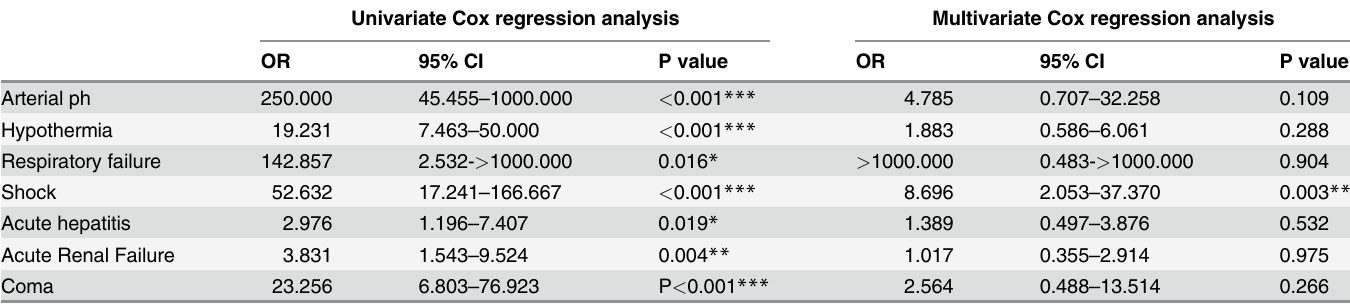
Table 5. Analysis of mortality for patients with CO poisoning (n = 261).